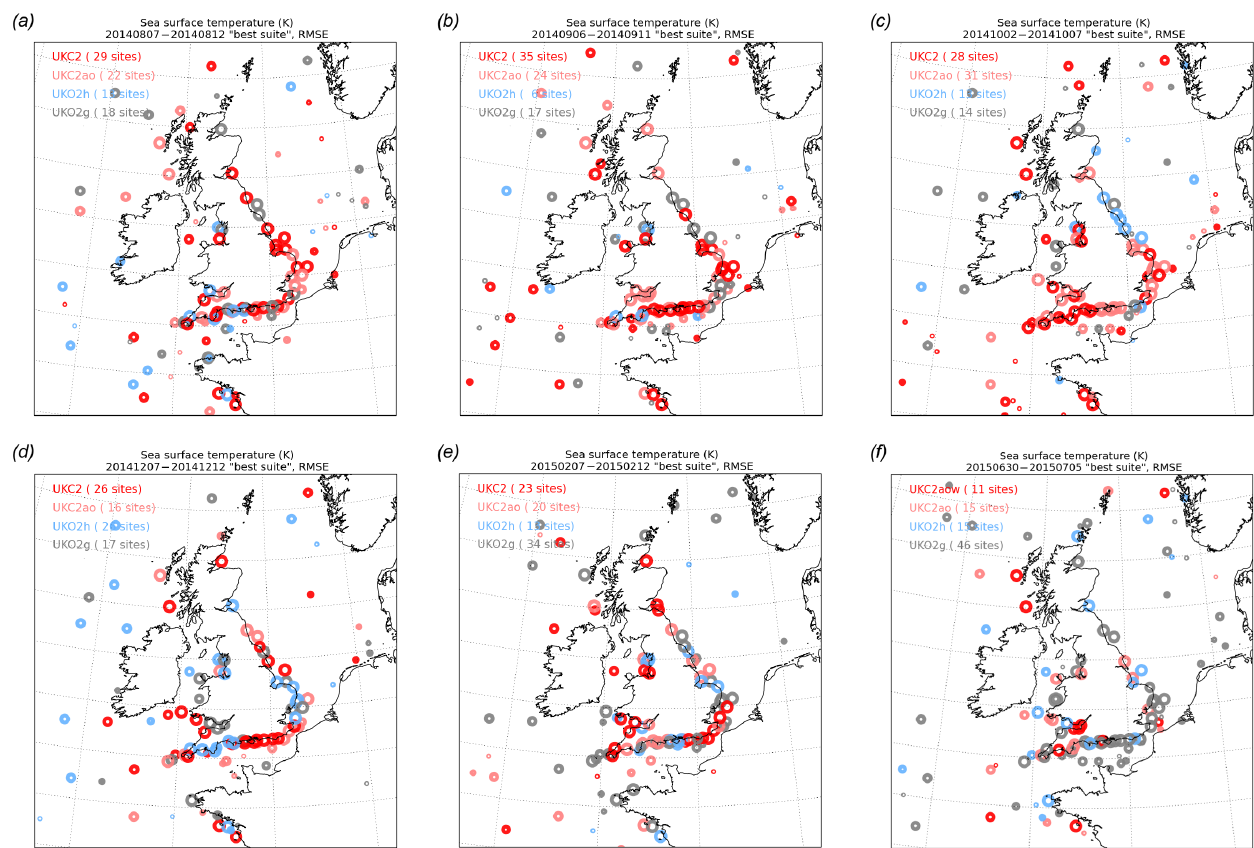
Figure 10. Distribution of in situ observation sites for which each of UKC2aow, UKC2ao, UKO2h or UKO2g ocean model SST outputs provided the lowest RMSE statistic for each 5-day case study. Note that only an inner section of the domain is presented for